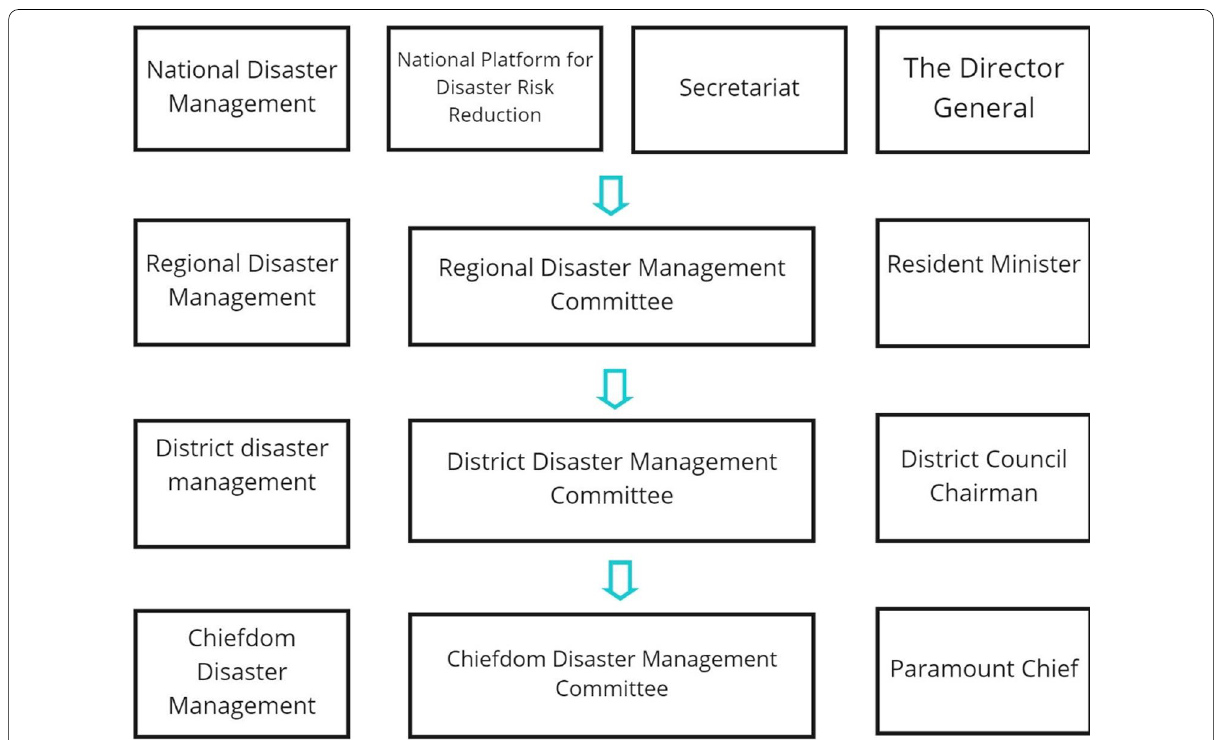
Fig. 2 The national disaster management agency framework. Source Authors’